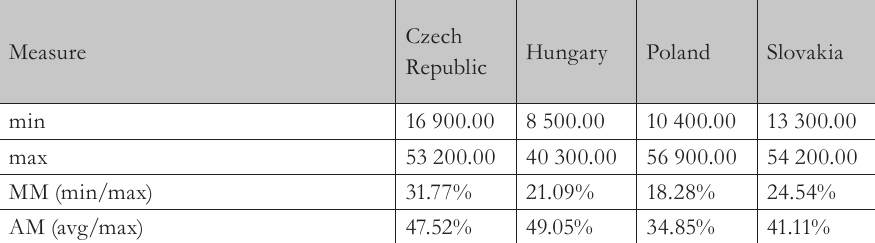
Tab. 7 – Selected measures of the GDP pc in the V4 countries at NUTS3 regional level.in 2015. Source: Own calculations based on Eurostat database (access: